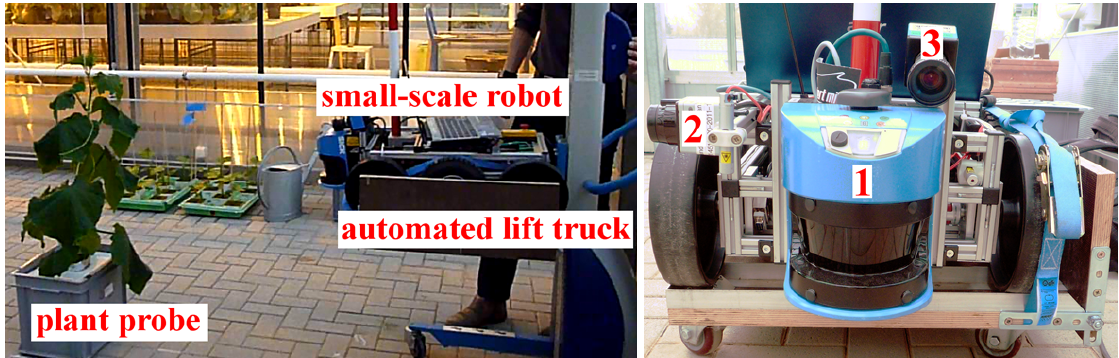
Figure 1. ( Left ): MSS on the vertical lift acquiring a plant probe. ( Right ): Front view of the MSS senors: (1) 2D laser scanner of type SICK LMS 500-20000 PRO-HR, (2) 2D laser scanner of type Hokuyo URG-04LX, (3) digital camera of type The Imaging Source DFK